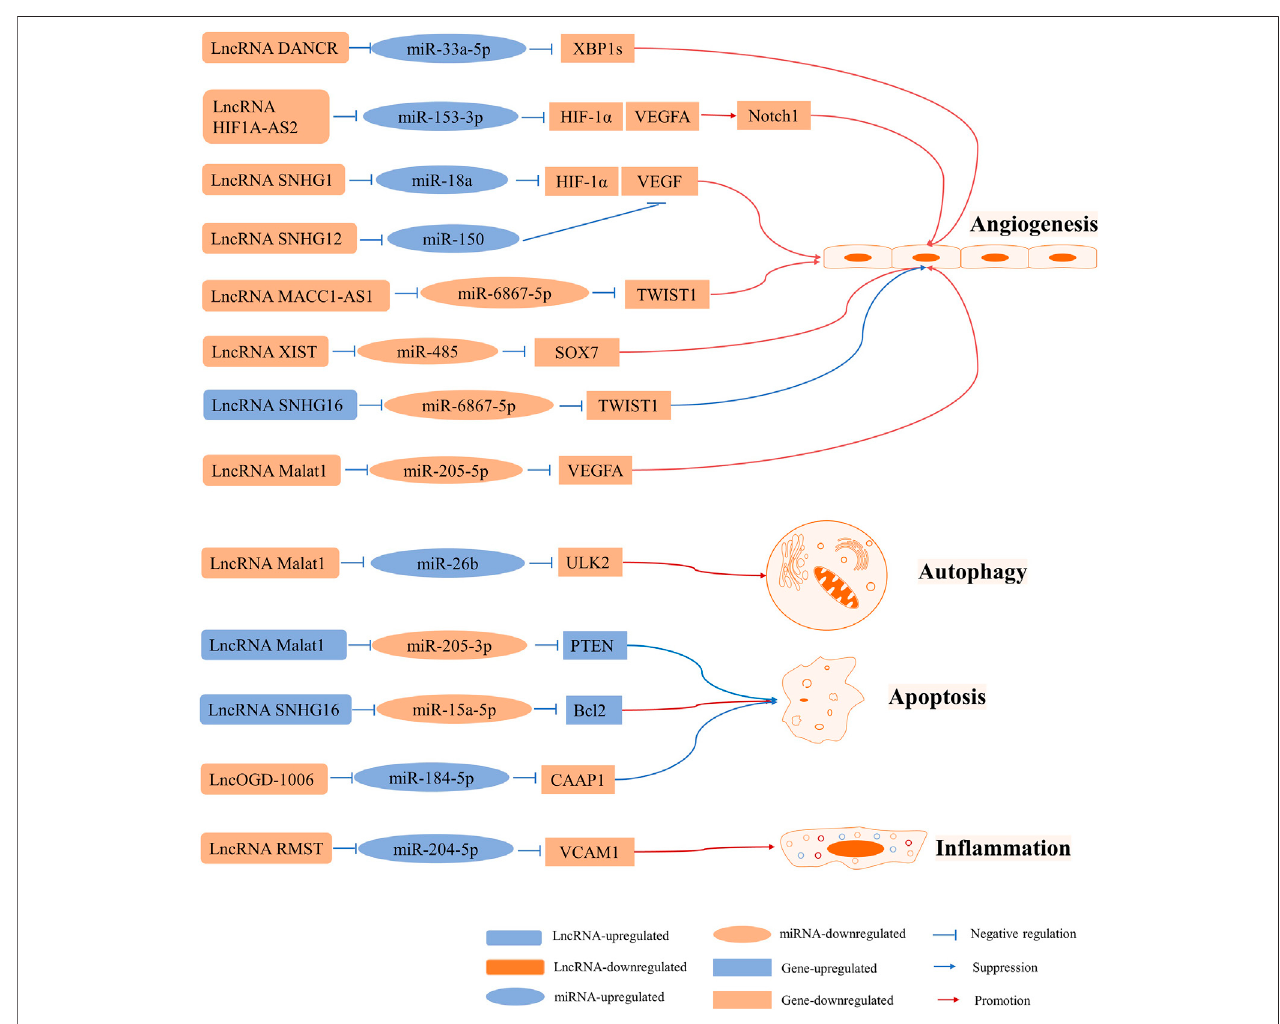
FIGURE 4 | LncRNA-mediated ceRNA networks in BMECs involved in angiogenesis, autophagy, apoptosis, and in fl ammation.